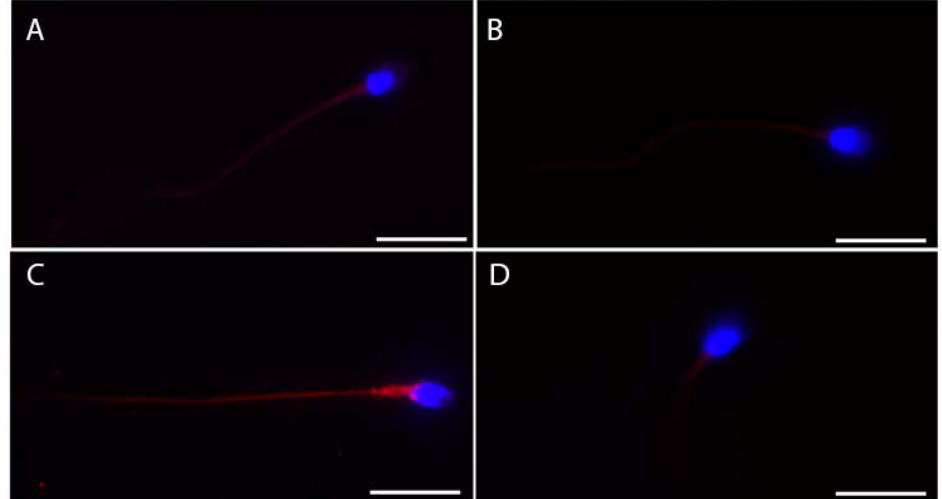
Figure 3. Representative micrographs (from three independent experiments) of immunofluorescence staining and confocal microscopy for the SARS-CoV-2 receptor ACE2 ( A ) and the other relevant host factors, BSG ( B ), CTSL ( C ), and TMPRSS2 ( D ), in ejaculated human sperm. ACE2, BSG, CTLS, and TMPRSS2 are in red; nuclei are in blue. Scale bar = 15 µ